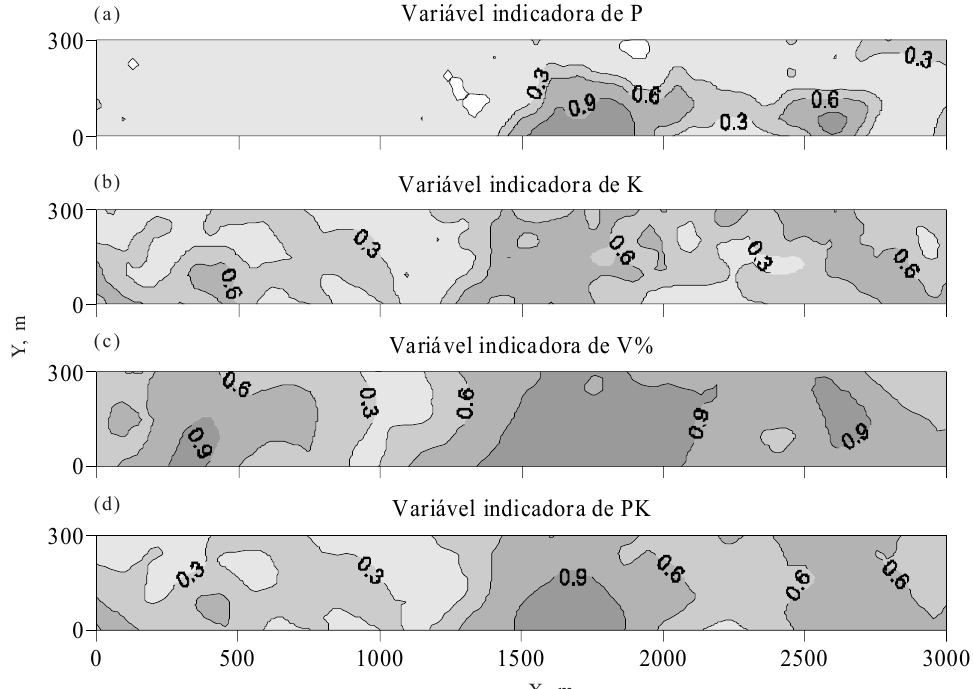
Figura 9. Mapas de probabilidade de as variáveis serem inferiores ou iguais aos valores de corte correspondentes aos níveis de fertilidade: (a) P[ Z(u) ≤≤≤≤≤ 15,0 ]; (b) P[ Z(u) ≤≤≤≤≤ 3,0 ]; (c) P[ Z(u) ≤≤≤≤≤ 50 ]; e (d) combinação das variáveis indicadoras de P e K; e) combinação das variáveis indicadoras de P, K e